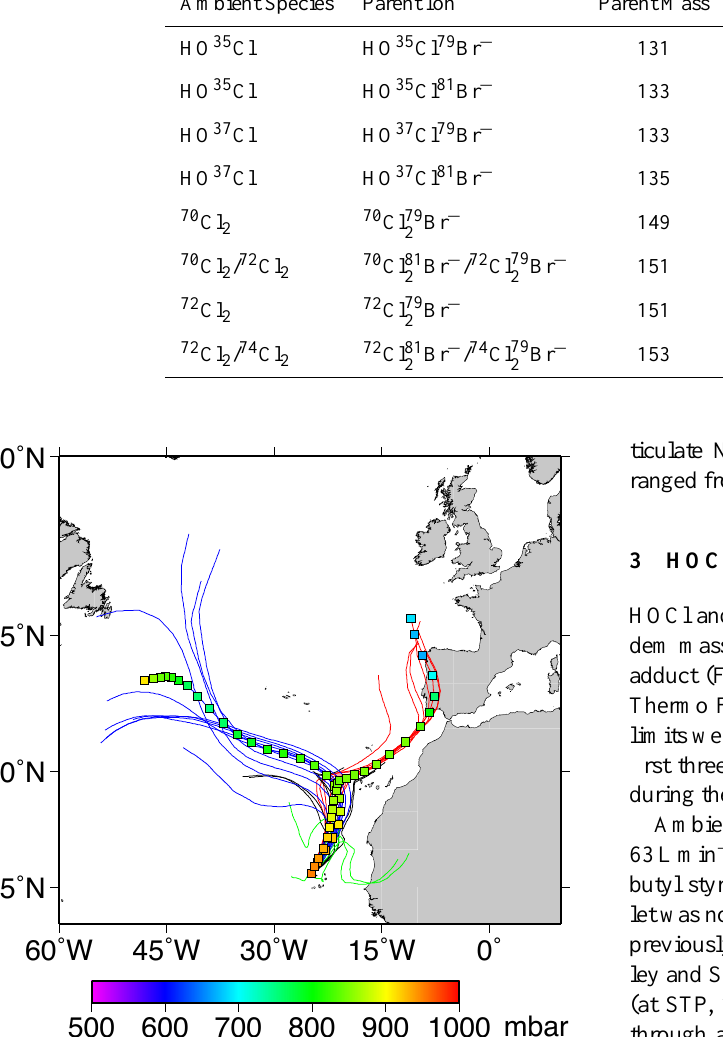
squares indicate air parcel elevation in mbar for trajectories on two characteristic days. Trajectories are from the British Atmospheric Data Centre, using the ECMWF archive